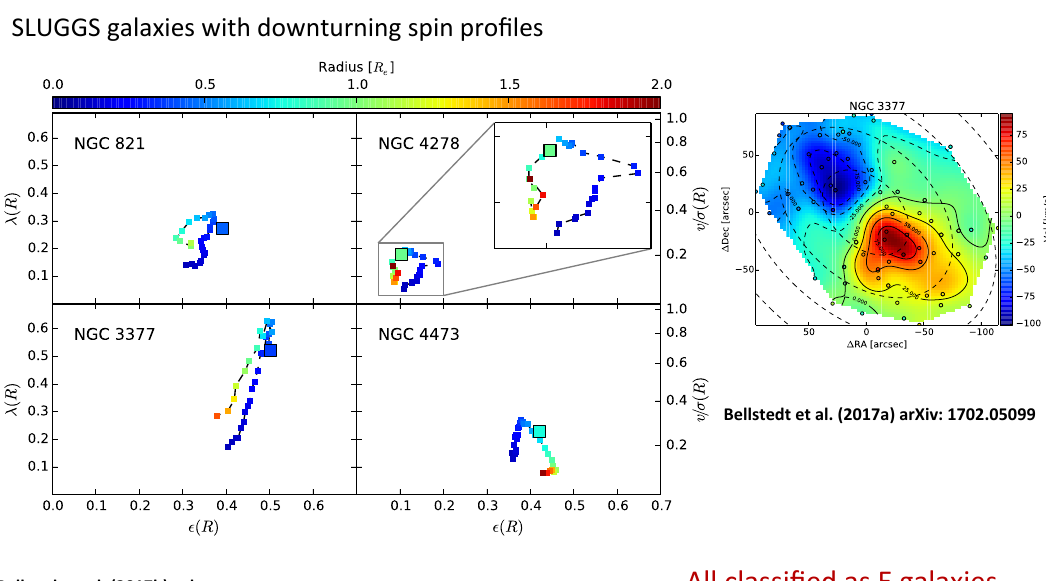
Figure 3. Spin–ellipticity diagrams for the four SLUGGS galaxies with downturning λ ( R ) profiles at larger radii. Note how the inner behaviour is akin to that of S0 galaxies, whereas the tracks at higher radii turn back to the region generally occupied by E galaxies. The right-hand figure is the velocity map for NGC 3377, which shows how the rotating nature of the galaxy does not extend to its outer